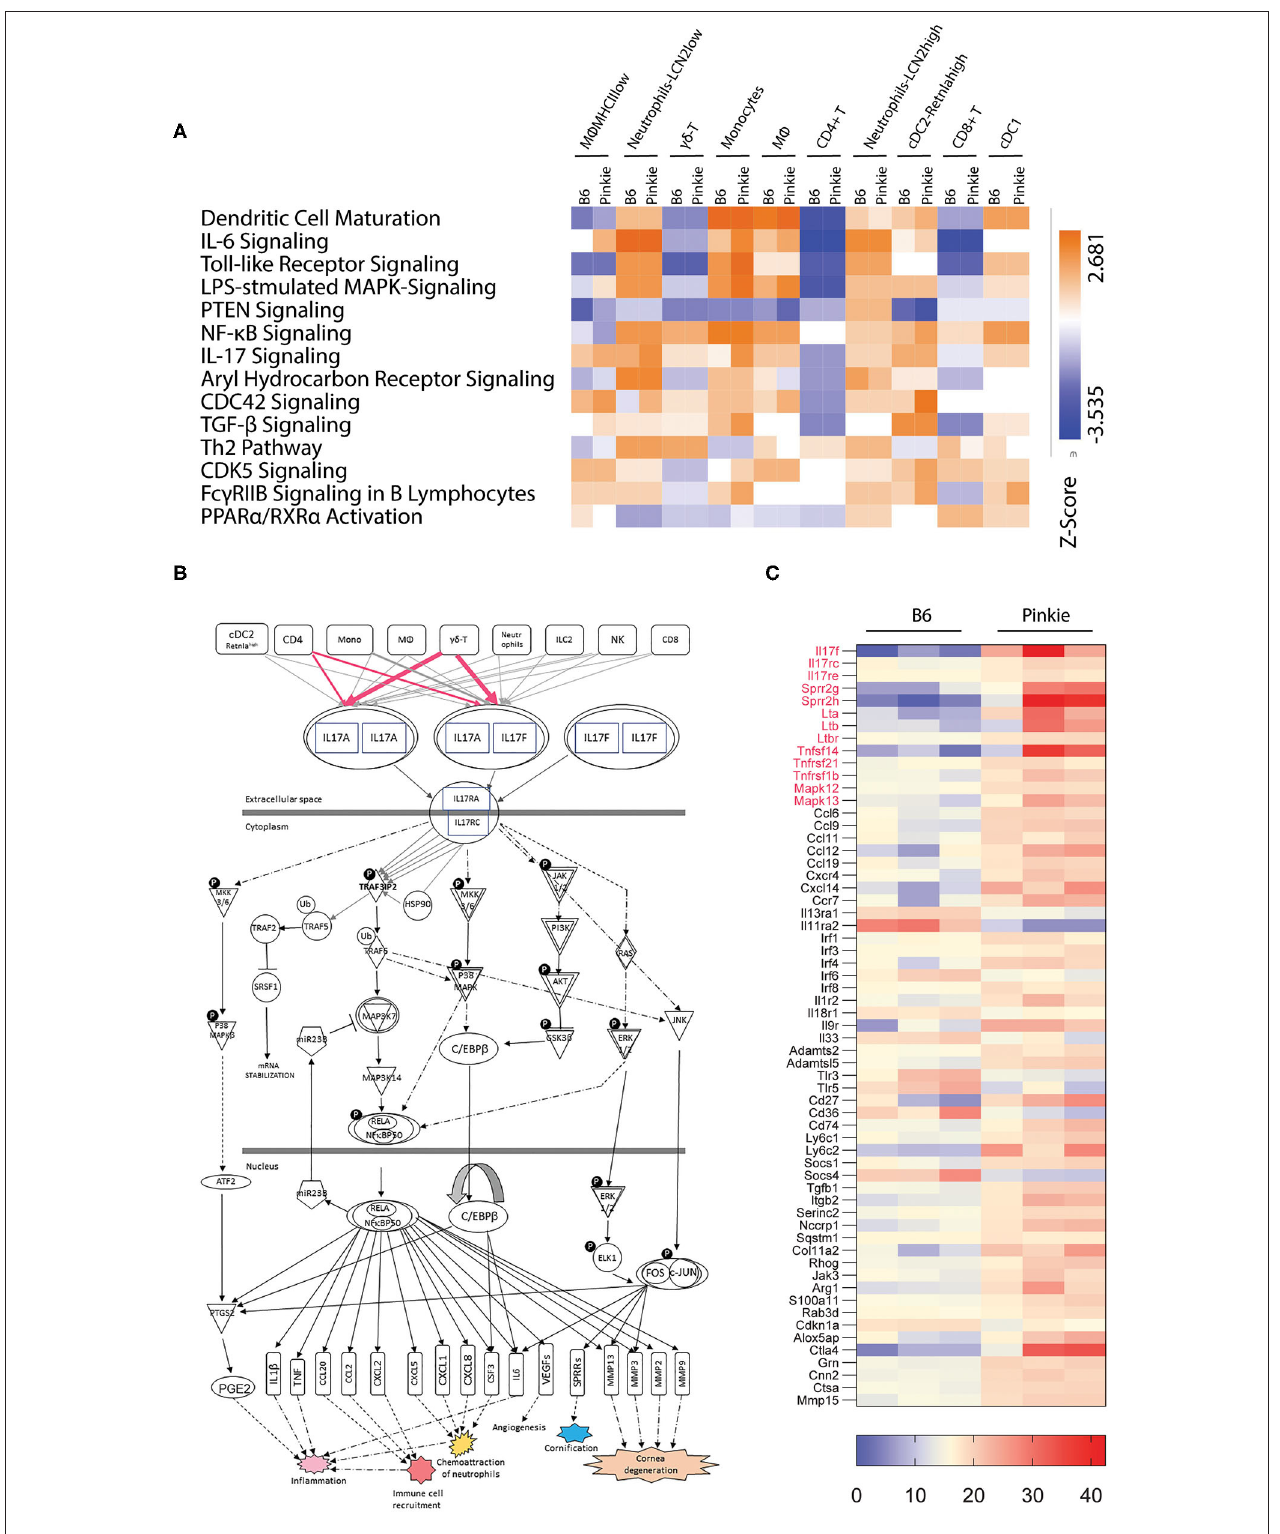
FIGURE 5 | Pathway analysis. (A) Heatmap of canonical pathways showing significant differences between strains and cell clusters was generated by Qiagen Ingenuity Pathway Analysis. This analysis identified the pathways from the Ingenuity Pathway Analysis library of canonical pathways that were most relevant to